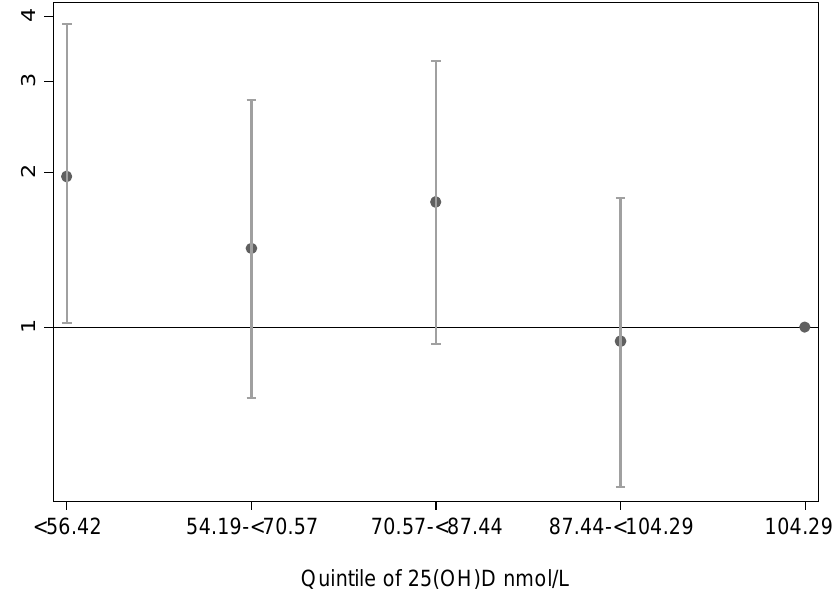
Figure 5. Odds of being a case with a first demyelinating event (a precursor of MS) by quintile of serum 25(OH)D, with the highest quintile as the reference category. Only the lowest quintile of 25(OH)D concentration is associated with a significant increase in risk (replotted from data from the Ausimmune Study [32]).